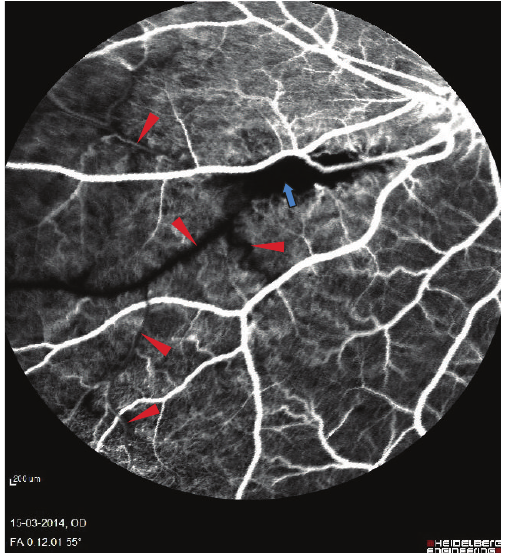
Figure 2: Delayed filling of occluded vein. The delayed filling is marked with red triangle. The site of occlusion is marked with blue